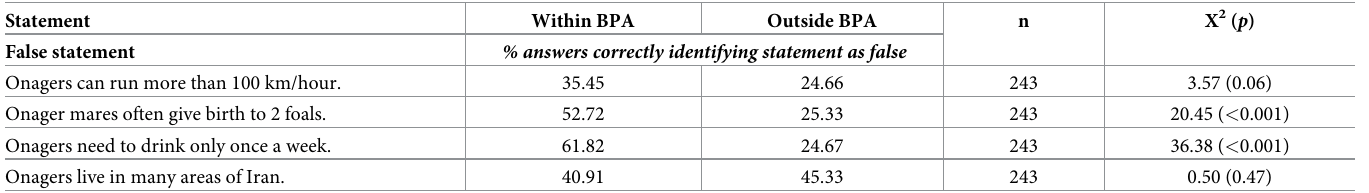
Table 1. Four false statements comprising the “knowledge score” about onagers for respondents within and outside Bahram-e-Goor Protected Area (BPA) in south- ern Iran. N = 243 respondents. Chi-square tests compare results within and outside BPA. Statement Within BPA Outside BPA Χ 2 ( p ) False statement % answers correctly identifying statement as false Onagers can run more than 100 km/hour. Onager mares often give birth to 2 foals. Onagers need to drink only once a week. Onagers live in many areas of Iran.